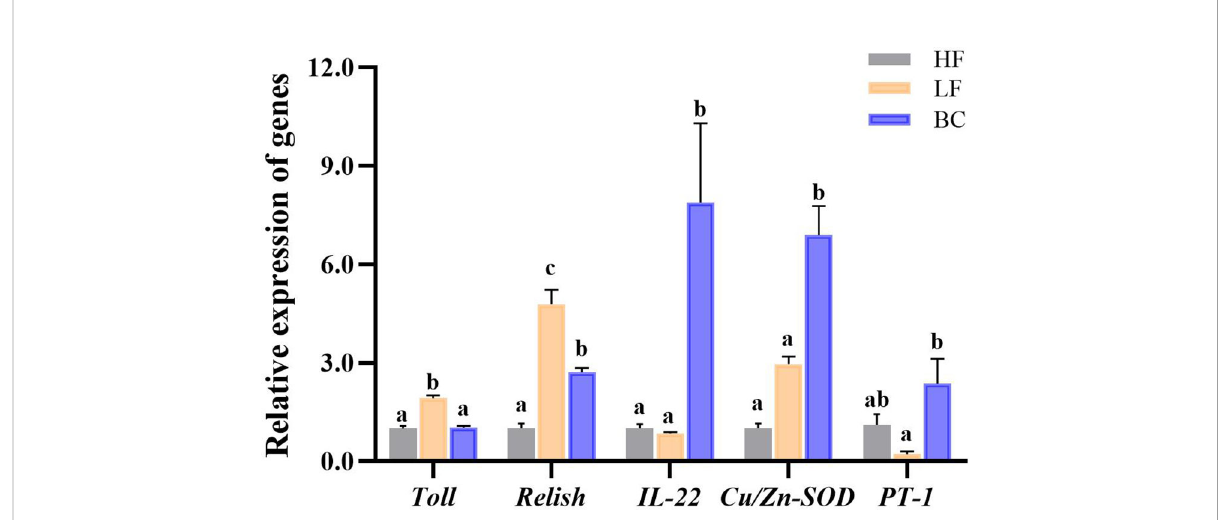
FIGURE 3 Intestinal gene expression pro fi le. Different lowercase letters indicate signi fi cant differences (P < 0.05) between the three